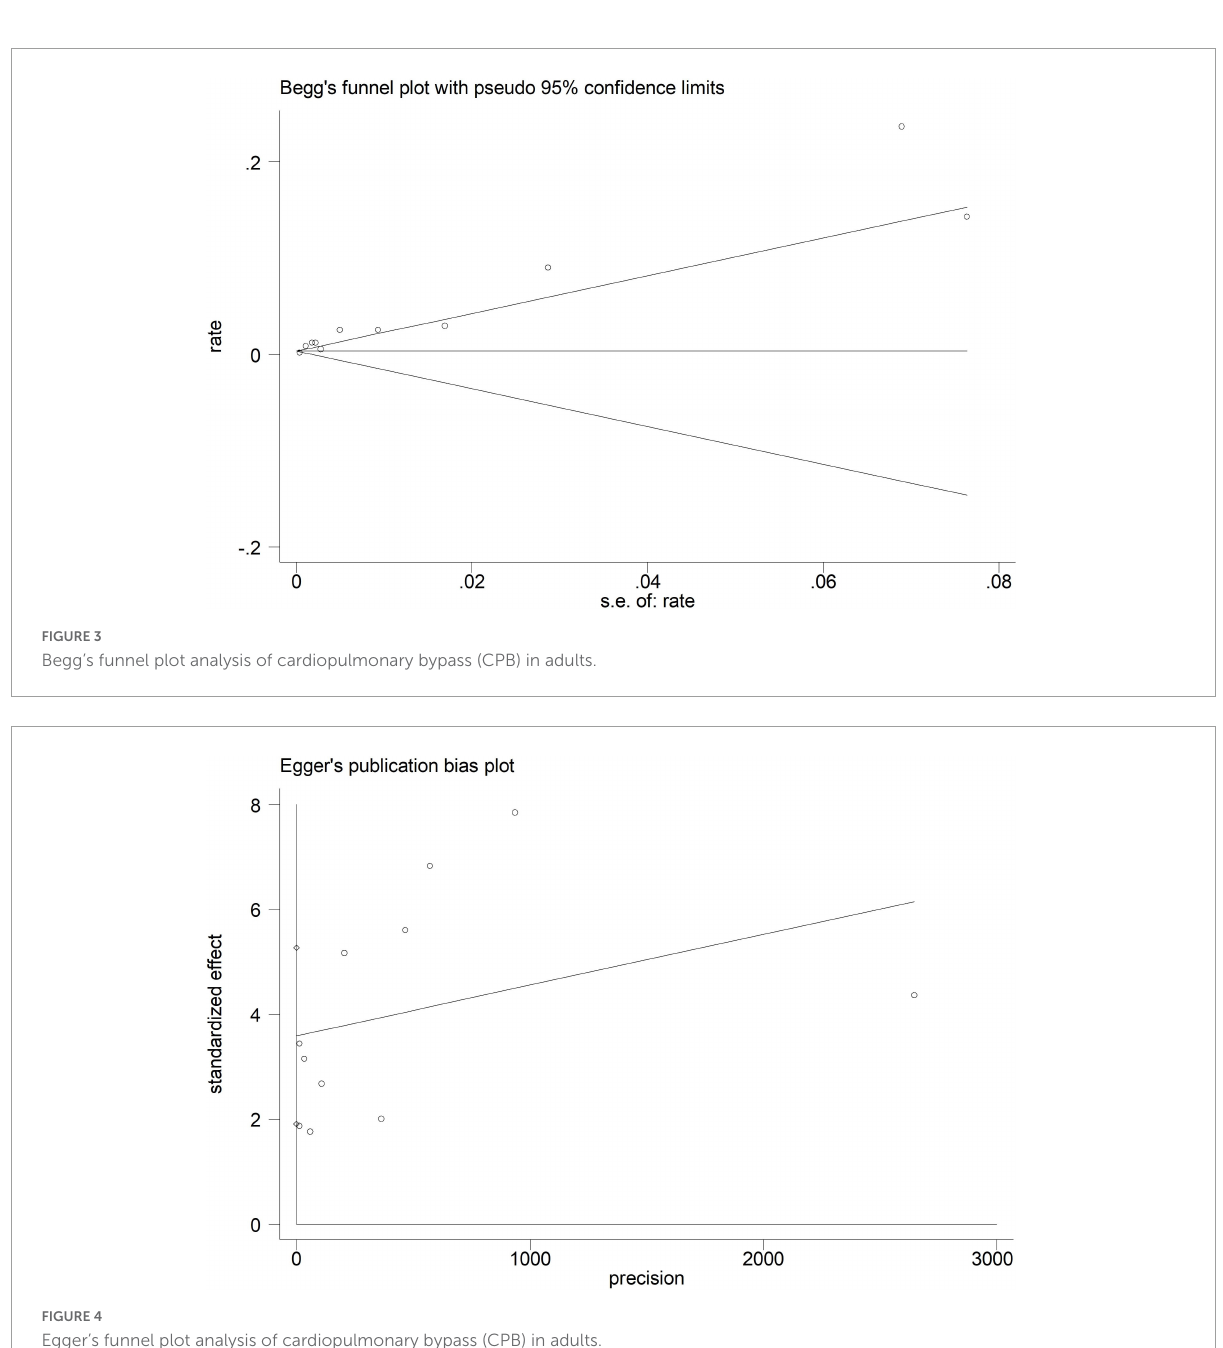
were included in the random-effect univariate meta-regression analysis for EEG seizure after CPB in pediatrics. As a result, the identified major sources of significant heterogeneity were gestational age (week) (coefficient = 0.0544, p = 0.080, adjusted R 2 = 29.02%) as shown in Table 1 . Subgroup analysis indicated that pediatric subjects with a median gestational age (week) < 38.5 had a lower risk of EEG seizures after CPB than those with a median gestational